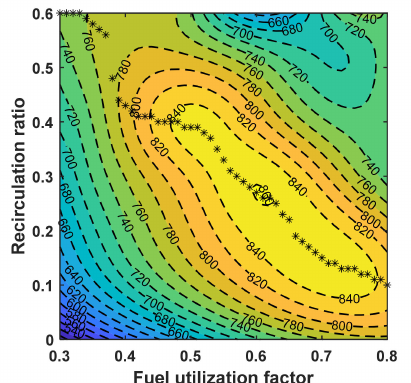
Figure 10. Generated power of AOGR #2 system with various fuel utilization factors and recircula- tion